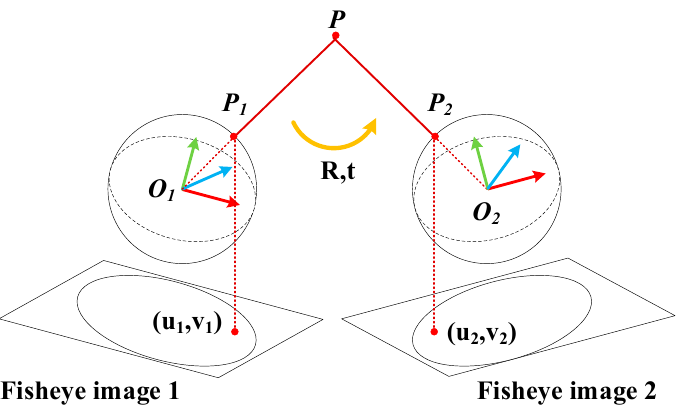
Figure 3. The fisheye spherical projection.